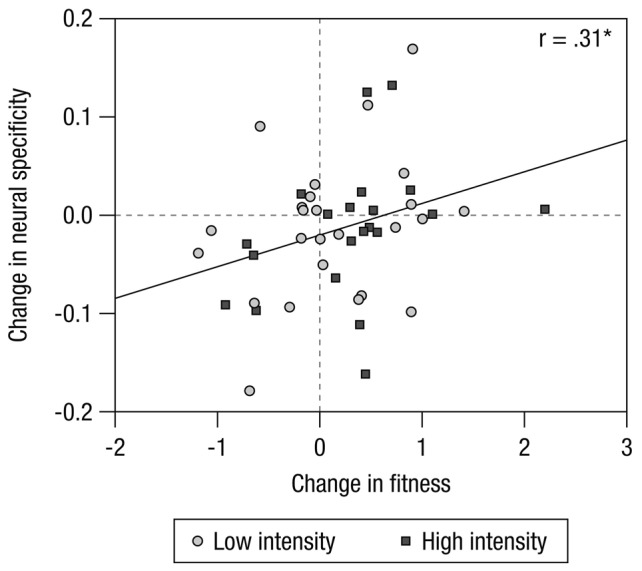
Changes in fitness (aggregate measure of VO2max and VO2AT) are positively associated with changes in neural specificity. Circles represent participants from the low-intensity (LI) exercise group, and squares represent participants from the high-intensity (HI) exercise group. Change scores refer to post-training minus pre-training differences; a score of zero signifies no change. *p < 0.05.